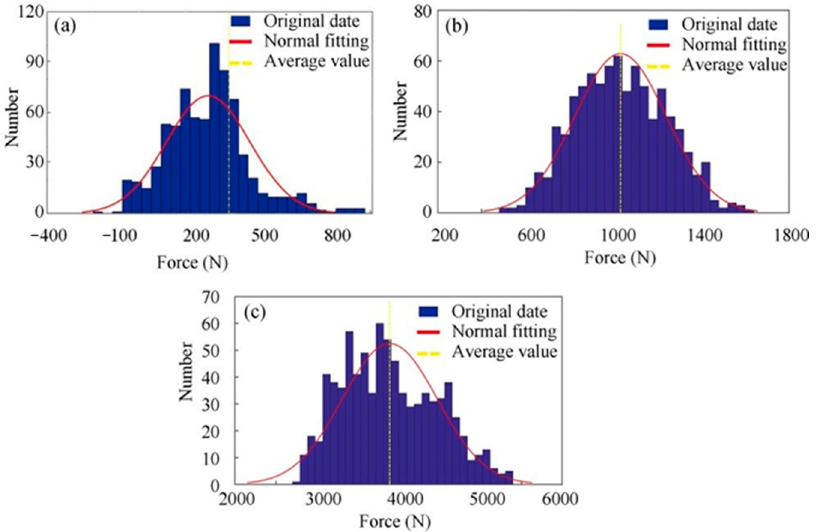
Figure 5. Normal distribution curve fitting of the forces when ω = 2000 rpm and ν = 30 mm/min: ( a ) F x , ( b ) F y and ( c ) F z . Table 3. Important factors and their levels.